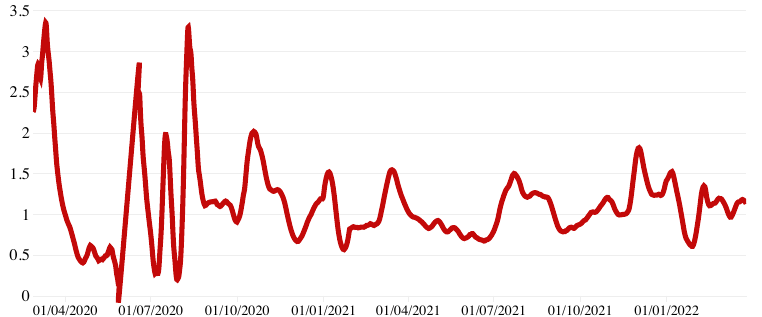
Figure 5. COVID-19 estimated R t in Calabria over a 7-day moving average, 24 February 2020–27 March 2022.